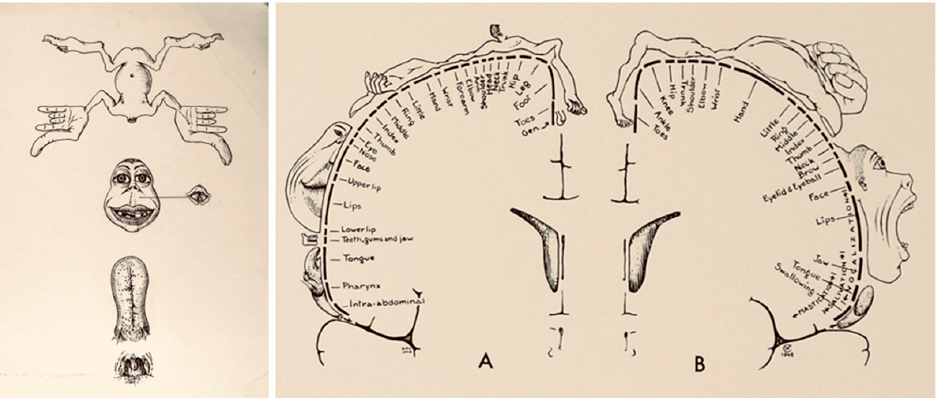
Figure 5. Evolution of homunculus. The illustration on the left is the 1937 homunculus, and the illustration on the right is the 1950 homunculus. The 1937 homunculus had a single figurine accounting for sensorimotor function. Illustrations adapted with permission from Leblanc (2021). The figurine is divided into four parts: body, face, tongue, and nasopharynx. The 1950 homunculus has distinct figurines showing the sensory and motor homunculus labelled as ( A , B ), respectively.